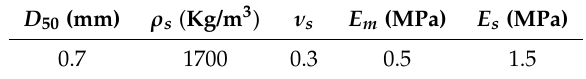
Figure 1. Laboratory set-up in dry sand, where the tank at the bottom has a volume of 1 m × 1 m × 1 m and can be filled up to 0.7 m by sand. Table 2. Dry sand